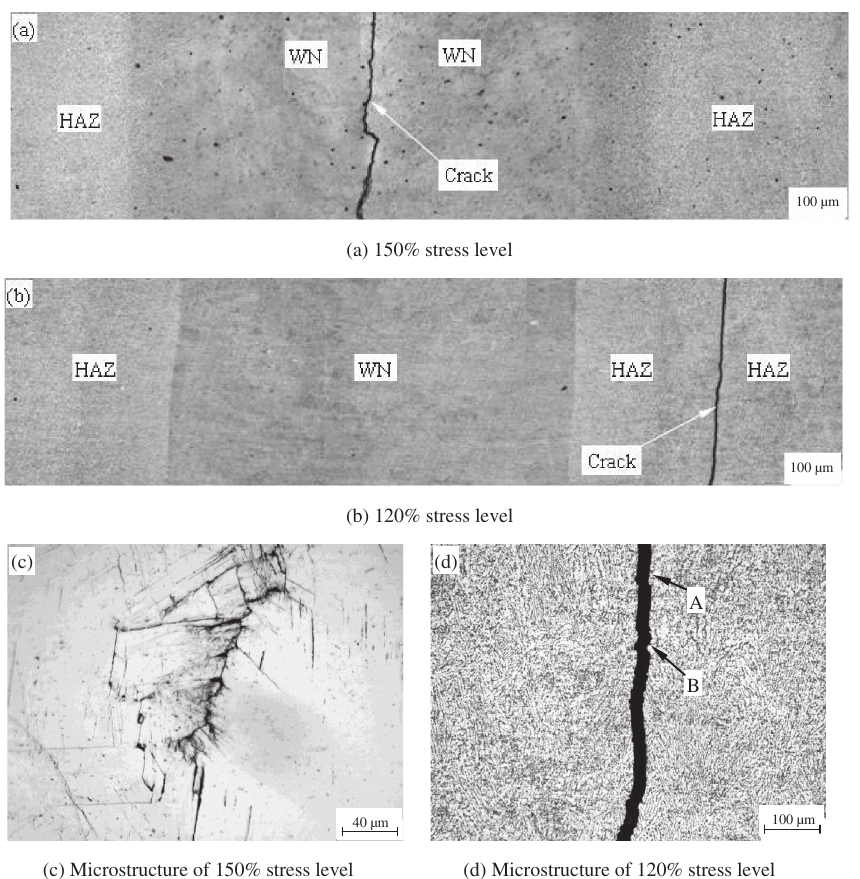
Figure 6: Fatigue failure characteristics of 150% and 120% stress